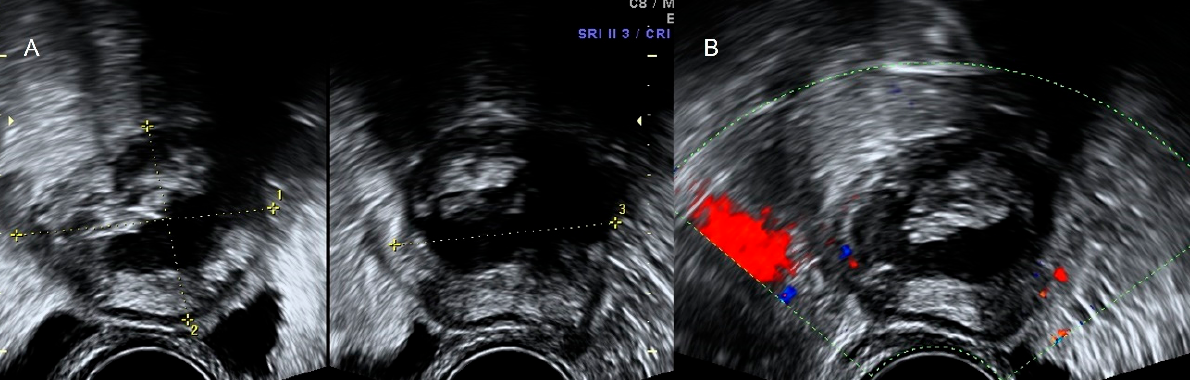
Figure 29. Transvaginal ultrasound imaging ( A , B ) shows a heterogeneous solid mass with acoustic shadows in a patient with recent pelvic surgery. Color Doppler does not demonstrate vascularization ( B ). This image corresponds to a surgical gossypiboma.